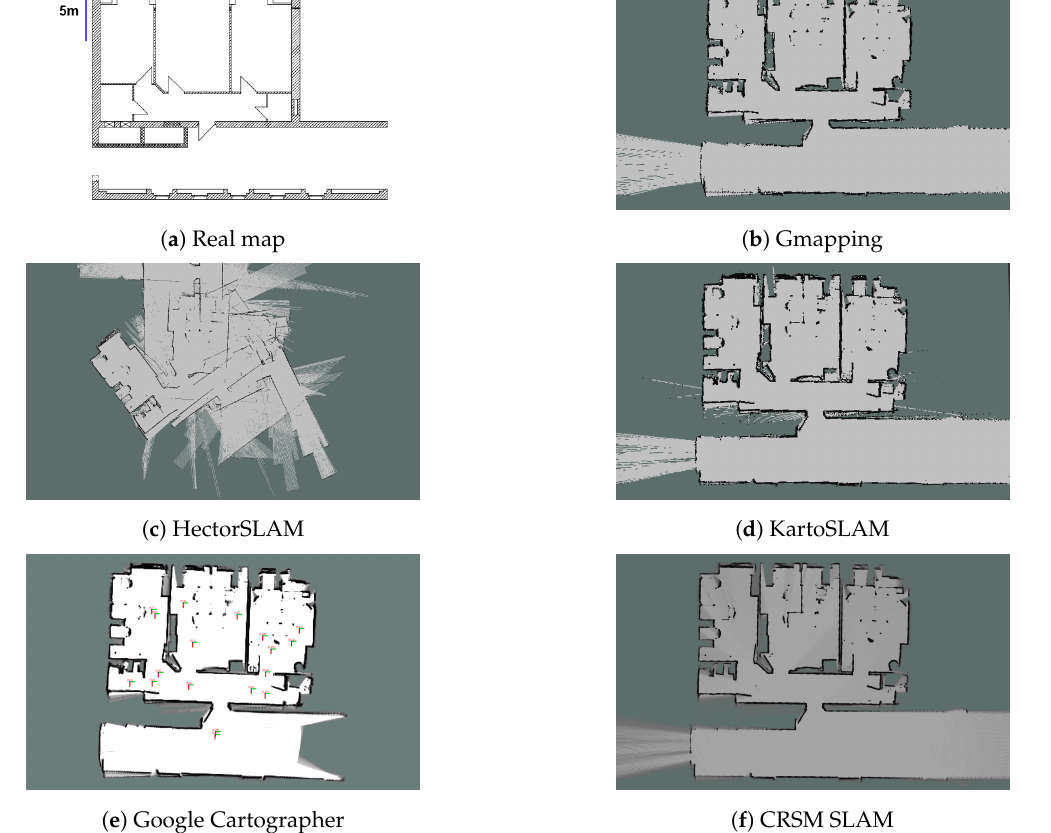
Figure 3. Resulting maps with 2D SLAM algorithms from a pre-recorded dataset [63]. The parameter values are the default ones. The sensor is located at 60 cm of height, has a resolution of 0.4 ◦ , a horizontal FoV of 360 ◦ and a frequency of 10